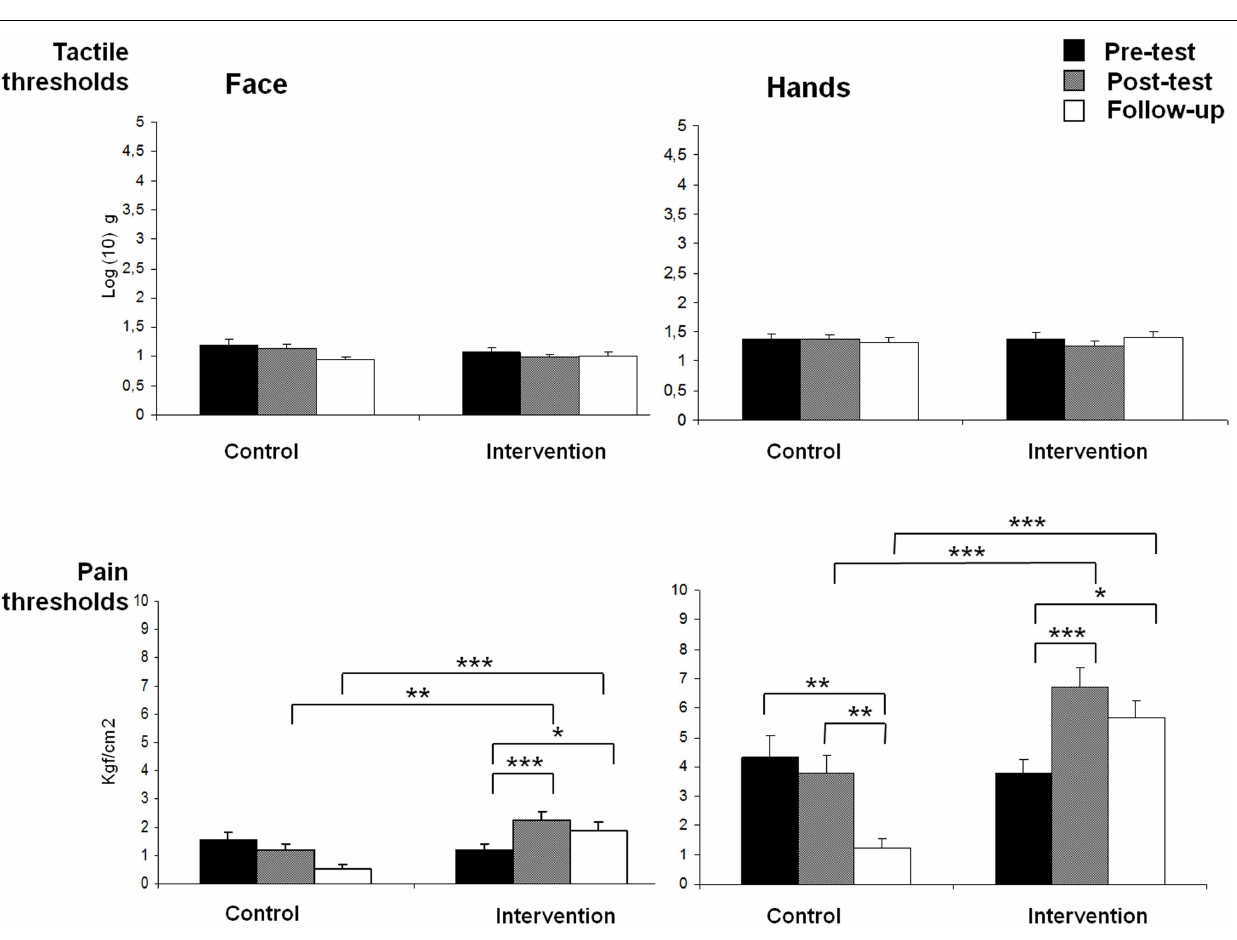
FIGURE 1 | Means of pain and tactile thresholds for each group (control and intervention), assessment time (pre-test, post-test, and follow-up) and body side (face and hands) (* p < 0.05, ** p < 0.01, *** p < 0.001)